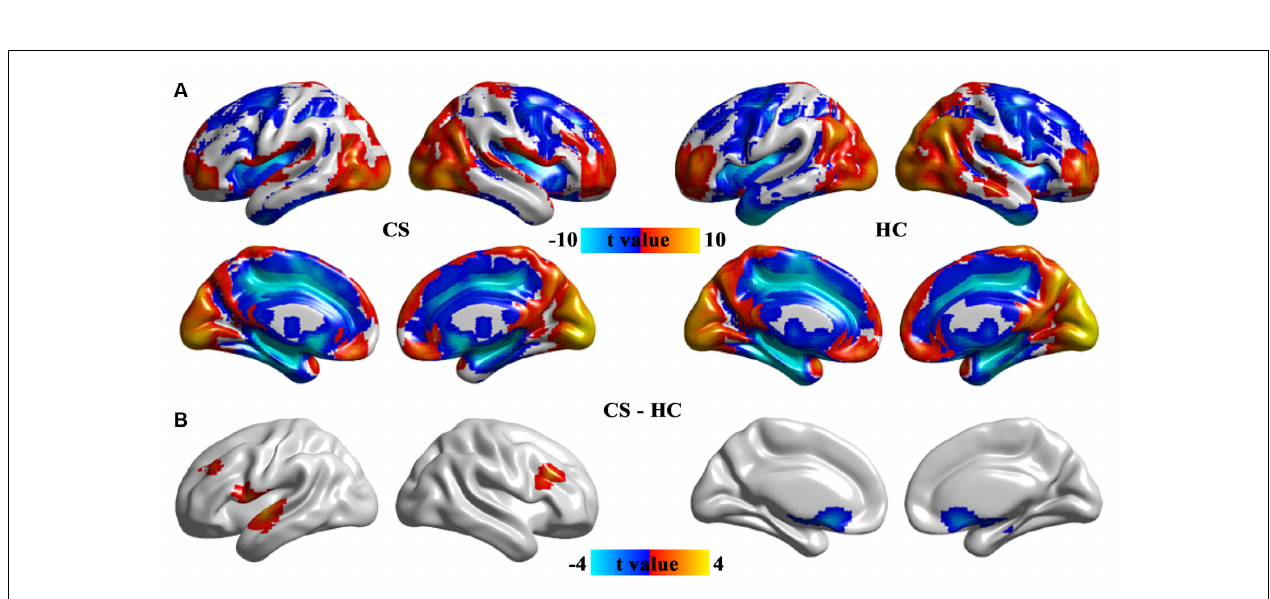
FIGURE 2 | The pattern of ALFF in the CS and HC groups (A) and brain regions with significant group differences in ALFF (B) . Group differences in ALFF between the CS and HC groups were identified using a two-sample t-test. The statistical significance level was set at p < 0.05, GRF corrected. ALFF, the amplitude of low-frequency fluctuation; CS, concomitant strabismus; HC, healthy